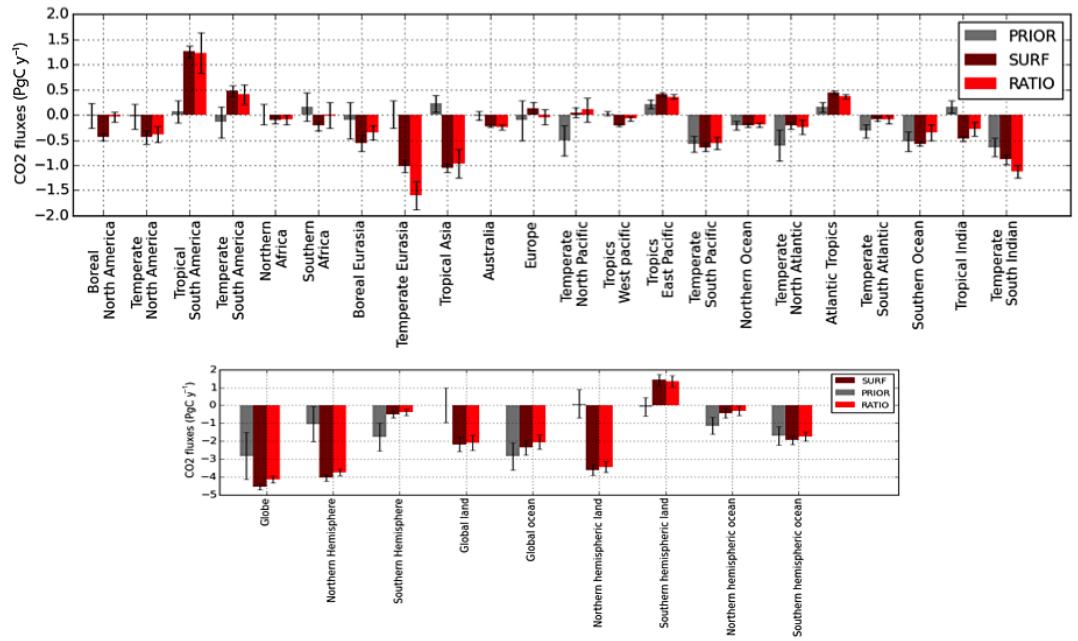
Figure 5. Annual fluxes of CO 2 (excluding fossil fuel emissions) integrated over different regions.